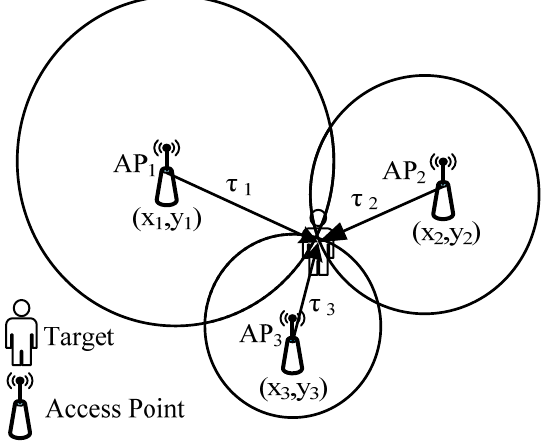
Figure 3. TOA ‐ based trilateration. Figure 3. TOA-based trilateration.